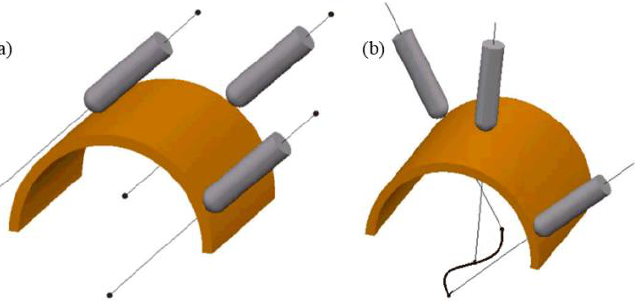
Figure 4. Tool axis orientation diagram: ( a ) vertical to the Z-axis; ( b ) changes with the surface direction.